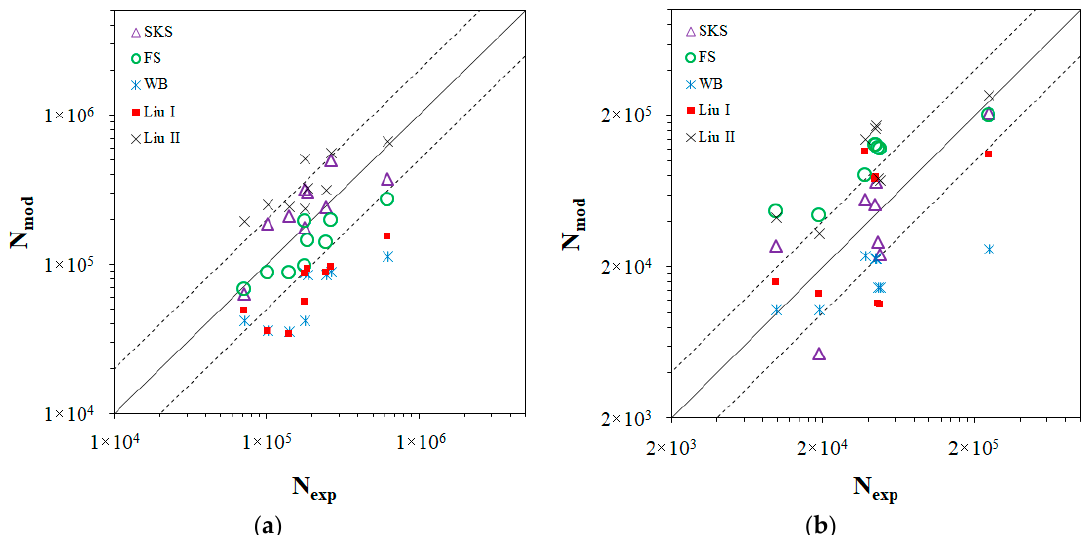
Figure 4. Fatigue life predicted by each model, N mod , versus experimental fatigue life, N exp , for in- phase loading ( a ) and out-of-phase loading ( b ).